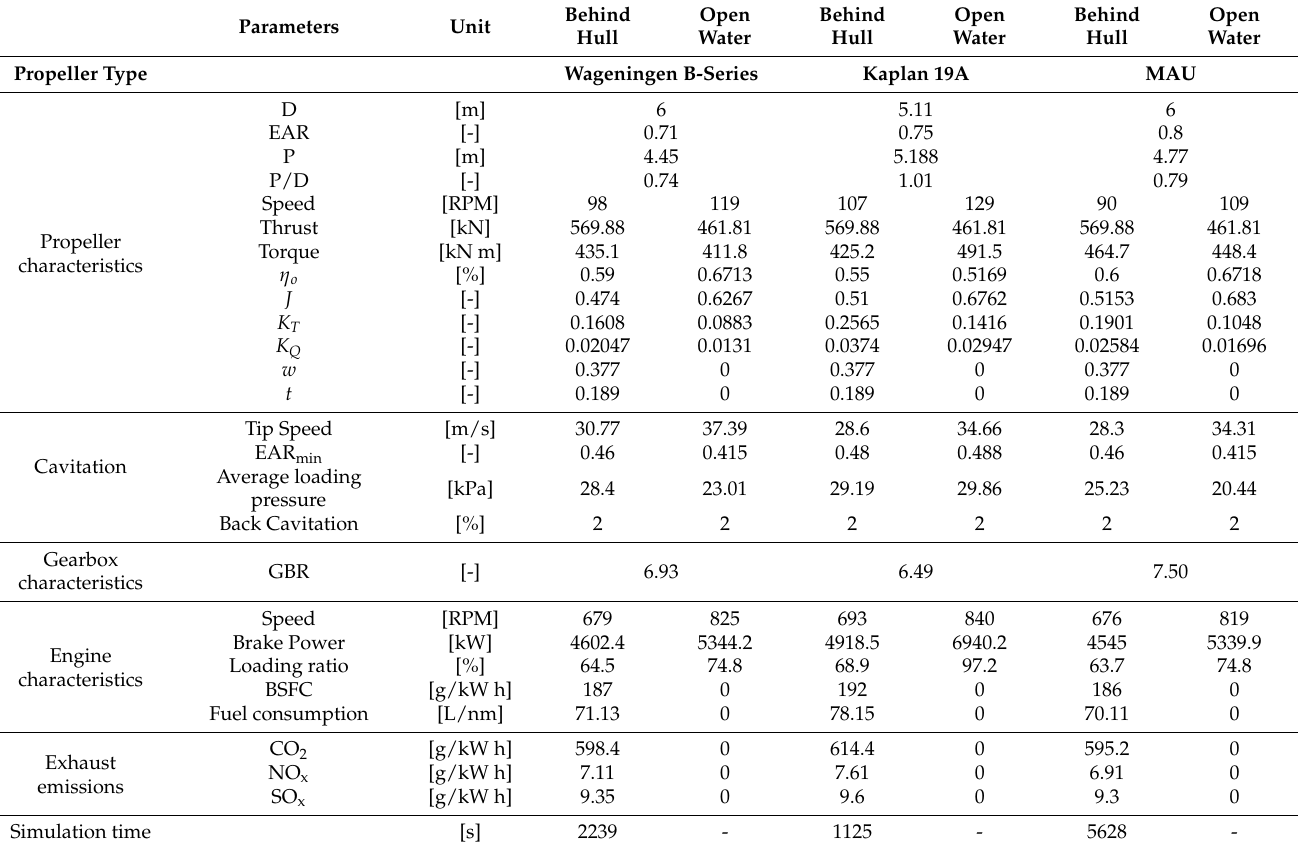
Table 4. Comparison between the optimized results for different propeller series. Behind